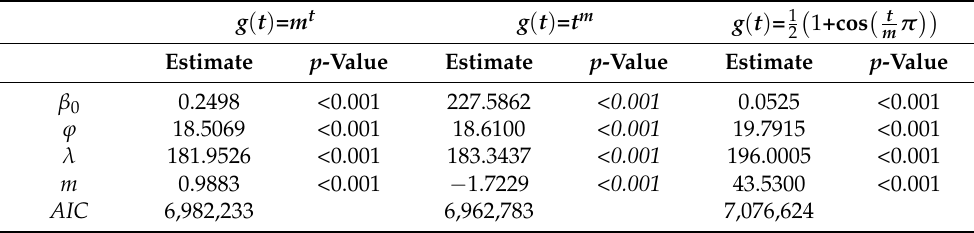
Table 3. Time-varying TR estimated by Equation (16).